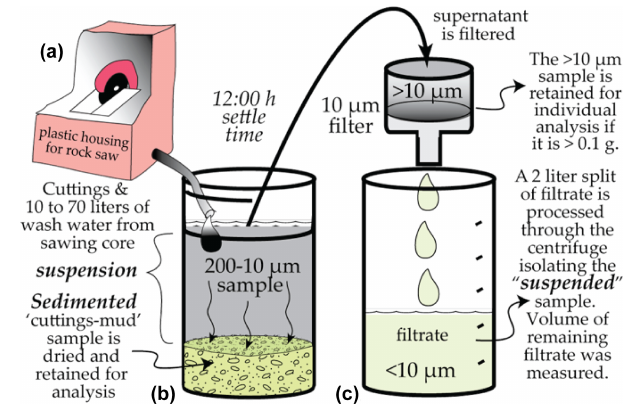
Figure 1. A schematic diagram showing the processes involved in collecting the channel sample of the drill core. Larger particles pro- duced in cutting the core (a) are sedimented in the plastic hous- ing, whereas smaller particles are flushed into a large carboy (b) . A coarser-grained sedimented subsample is produced by allowing the sample to settle for 12h. Clay-sized particles remaining in suspen- sion (c) are isolated by using a